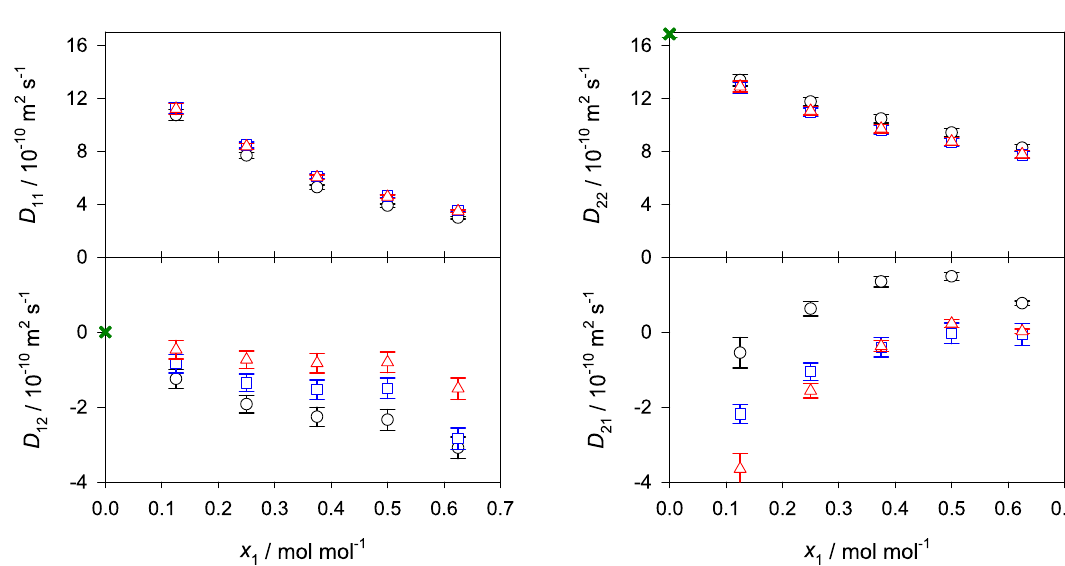
Figure 5. Elements of the Fick diffusion coefficient matrix in the molar (black circles), volume (blue squares) and mass reference frame (red triangles) of the ternary subsystem water (1) + methanol (2) + 2-propanol (3) 1 with x 3 = 0.25 molmol − at 298.15 K and 0.1 MPa. The green crosses represent the expected values in the binary limit x 1 → 0 for the molar reference